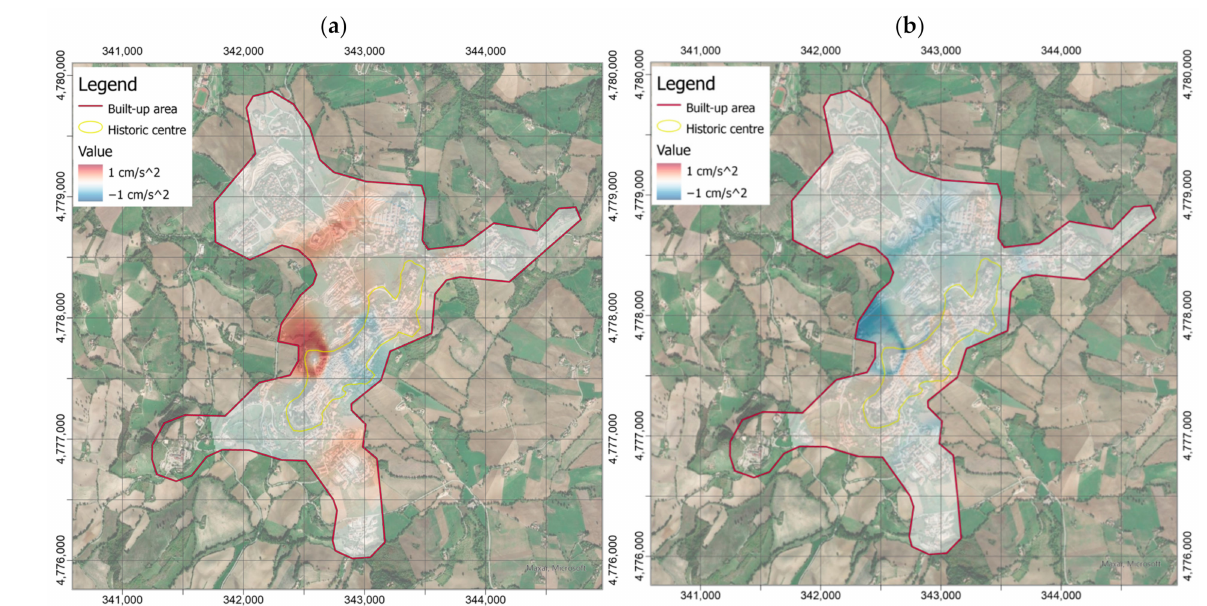
Figure 9. Differences in terms of PGAs (in cm/s 2 ) between the shakemap obtained by Inverse Distance Weighted (IDW) interpolation with power coefficient set to 4 and those with the same coefficient to 2 ( a ) and 8 ( b